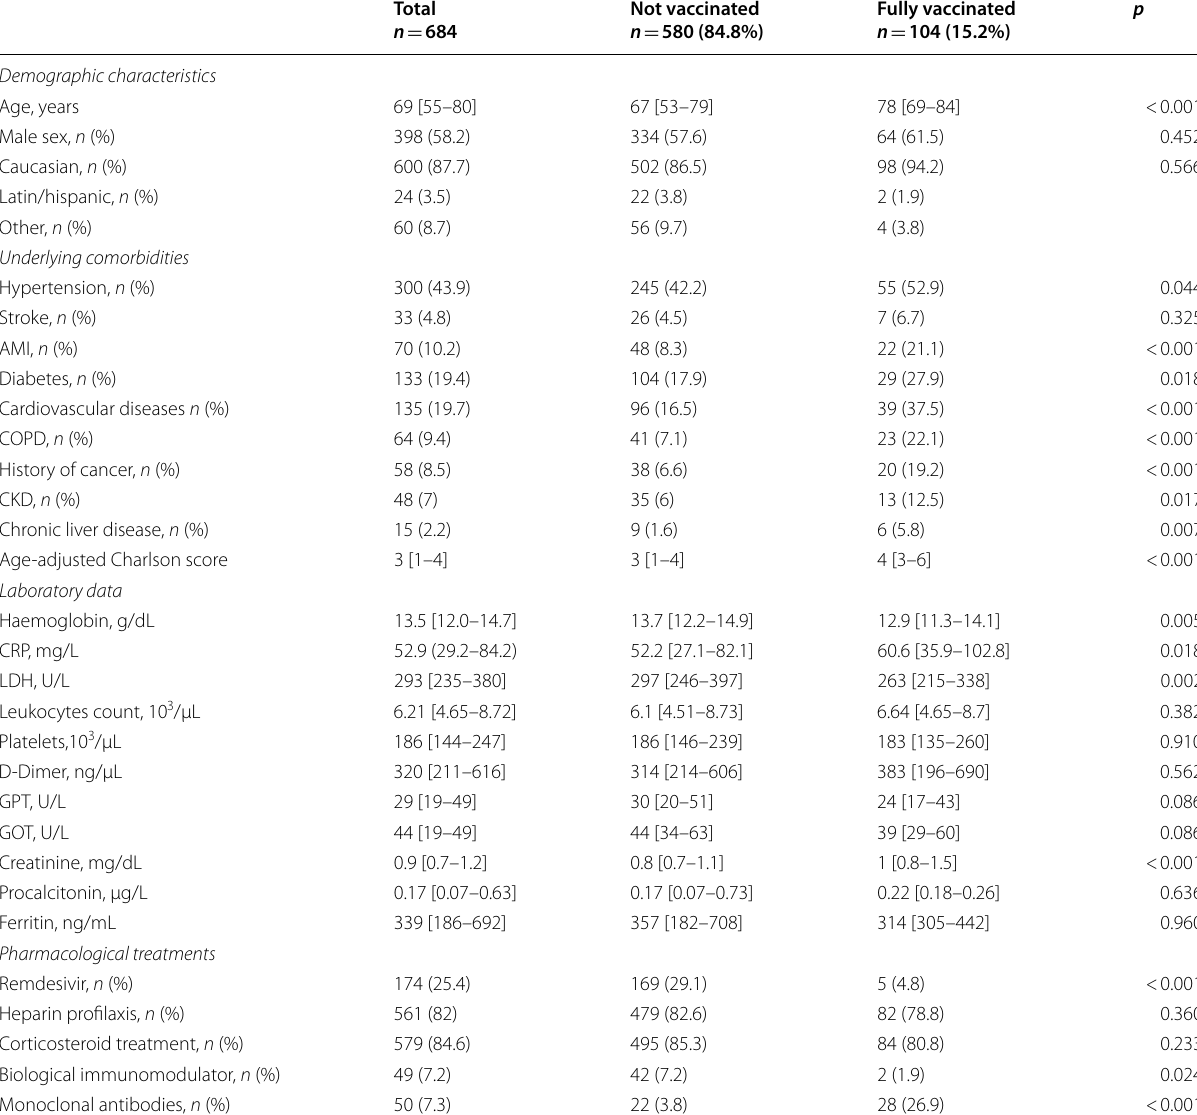
Table 1 Clinical characteristics at hospital admission of not vaccinated and fully vaccinated patients.